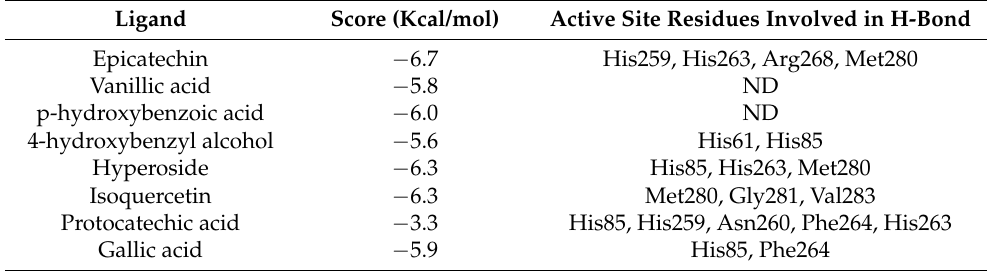
Table 3. Docking score and binding sites of the different ligands with tyrosinase.